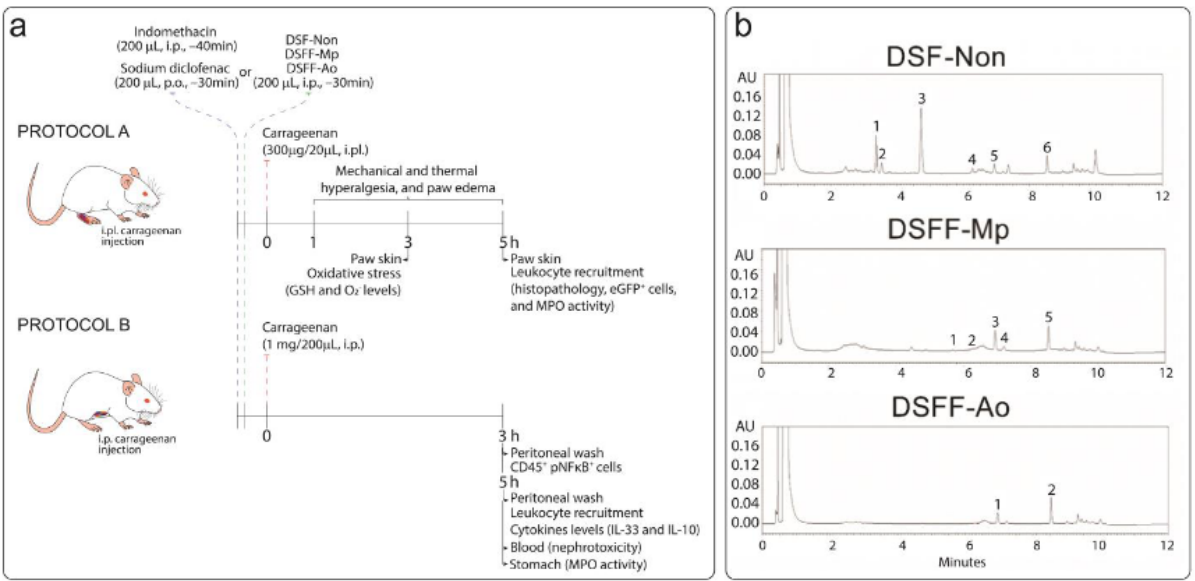
Figure 1. ( a ) Schematic representation of the experimental design used in the study. Protocol A refers to inflammatory pain model and protocol B refers to peritonitis model. ( b ) Chromatograms profiles of DSF-Non, DSFF-Mp, and DSFF-Ao. DSF-Non: peak 1–daidzin, peak 2–glycitin, peak 3– genistin, peak 4–malonyl genistin, peak 5–dadzein, and peak 6–genistein. DSFF-Mp: peak 1–malonyl daidzin, peak 2–malonyl genistin, peak 3–dadzein, peak 4–acetyl genistin, and peak 5–genistein. DSFF-Ao: peak 1–dadzein and peak